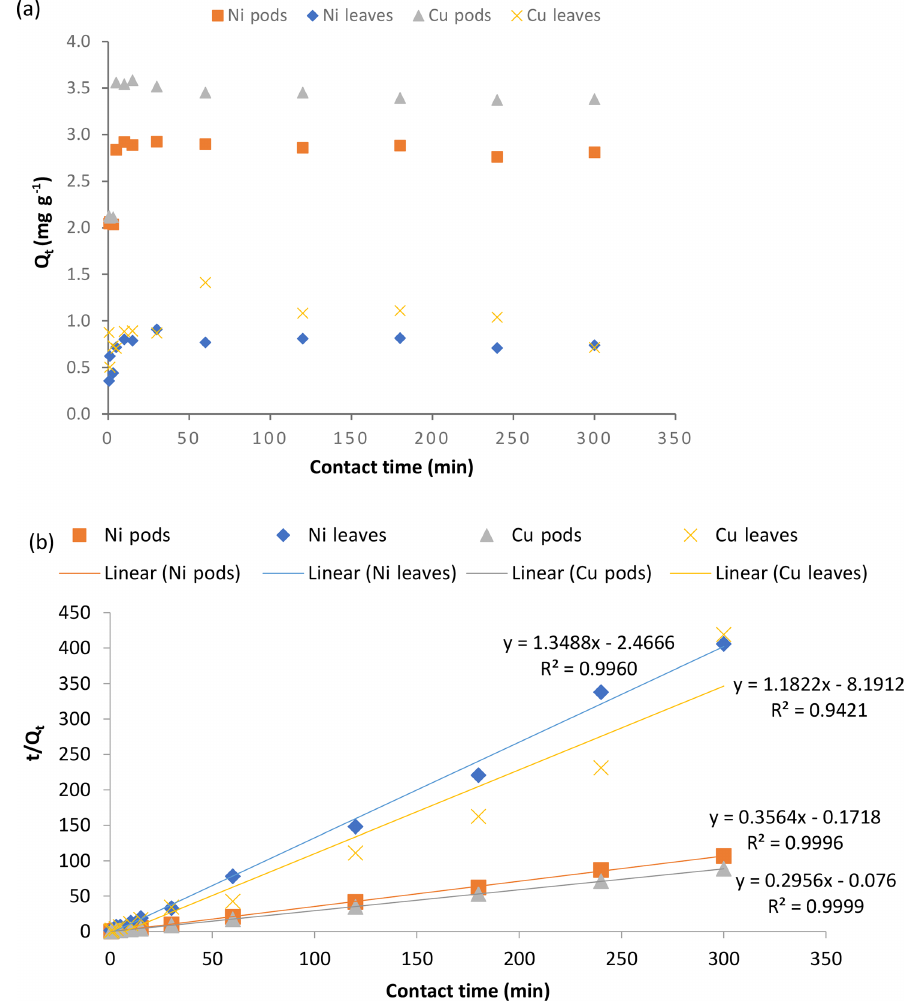
Figure 5. Effect of contact time (a) and pseudo-second-order kinetics (b) on the adsorption of Ni(II) and Cu(II) ions by Delonix regia pods and leaves. The experimental conditions were as follows: a pH of 4 and 5, a contact time of 5–300min, an adsorbent dosage of 0.5g and a metal ion concentration of 100mgL − 1 . Table 2. The isotherm models’ adsorption parameters for the adsorption of Ni(II) and Cu(II) onto Delonix regia